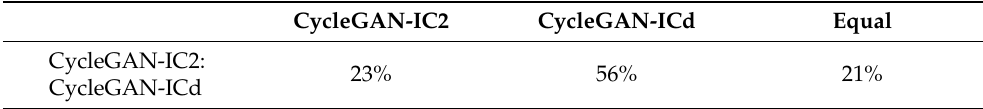
Table 9. The voting results of CMOS in singing to